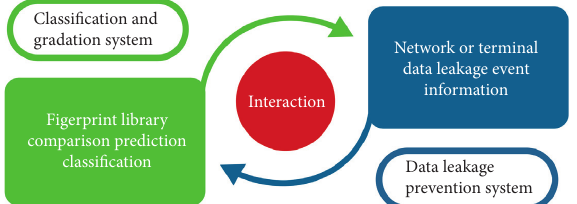
Figure 2: Interaction diagram of classification and gradation system and DLP system.